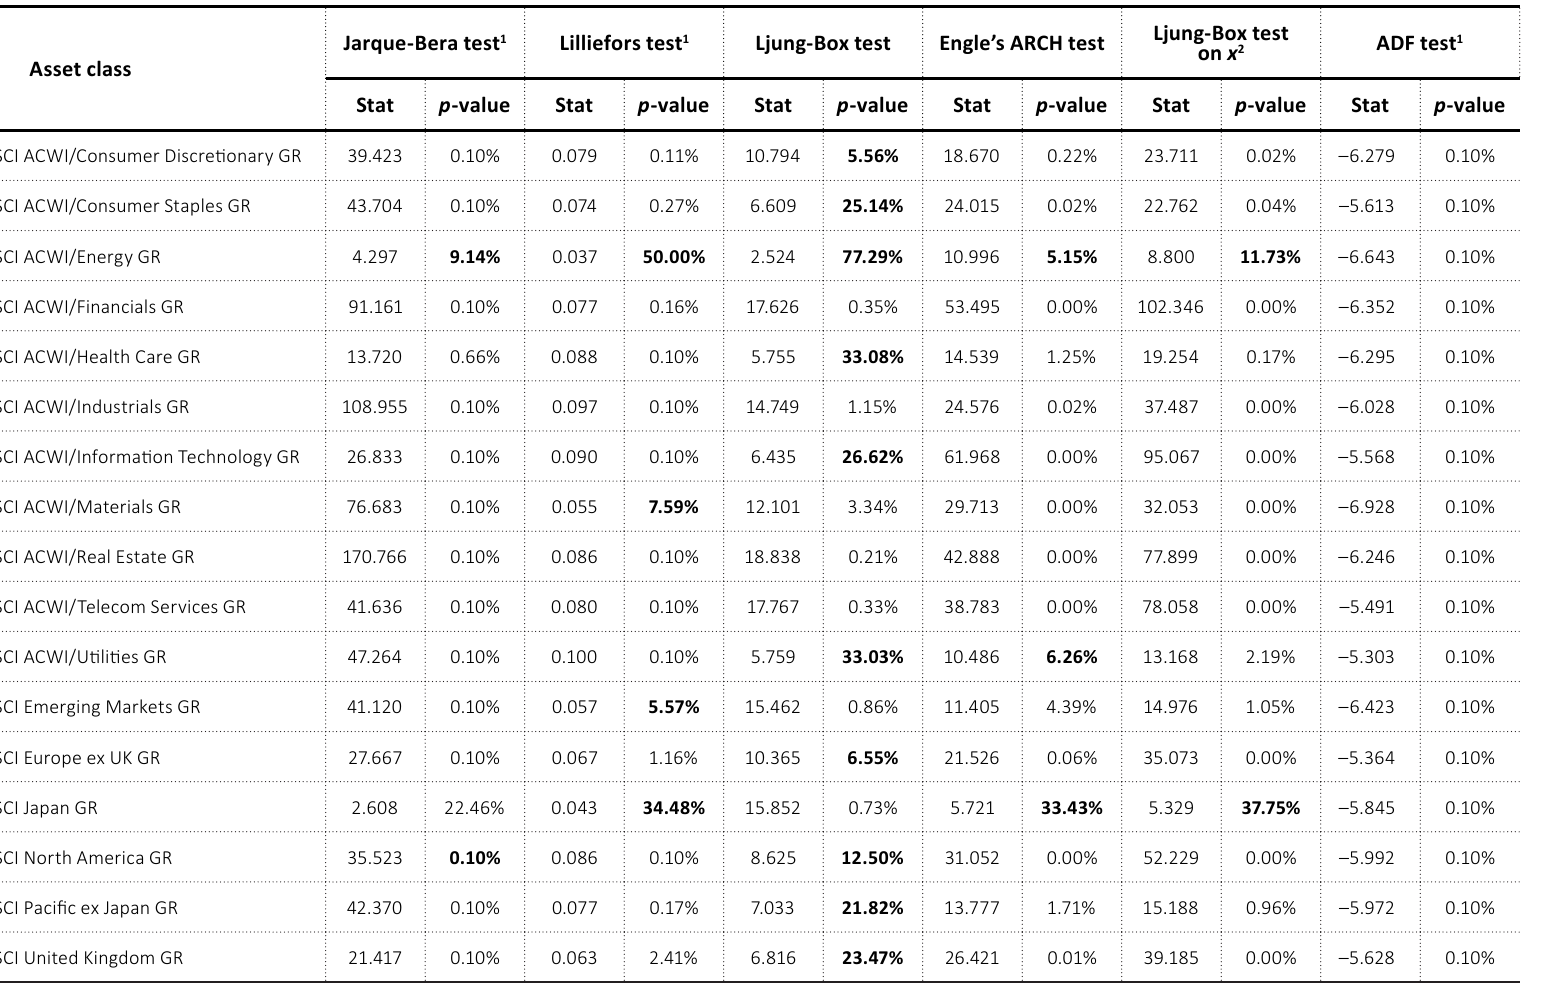
Table 5. Tests of deviations from normality of the benchmarks’ excess